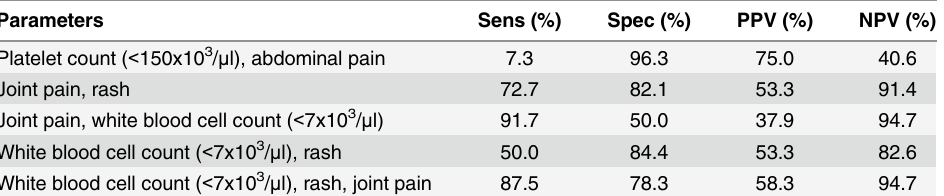
Table 5. Positive predictive values (PPVs), negative predictive values (NPVs), sensitivity, specificity and likelihood ratios of clinical features used to distinguish patients of the APCF of the EWMSC, T&T (Dec 2013 – Nov 2014) with DF l= infection from patients with CHIKF l= .